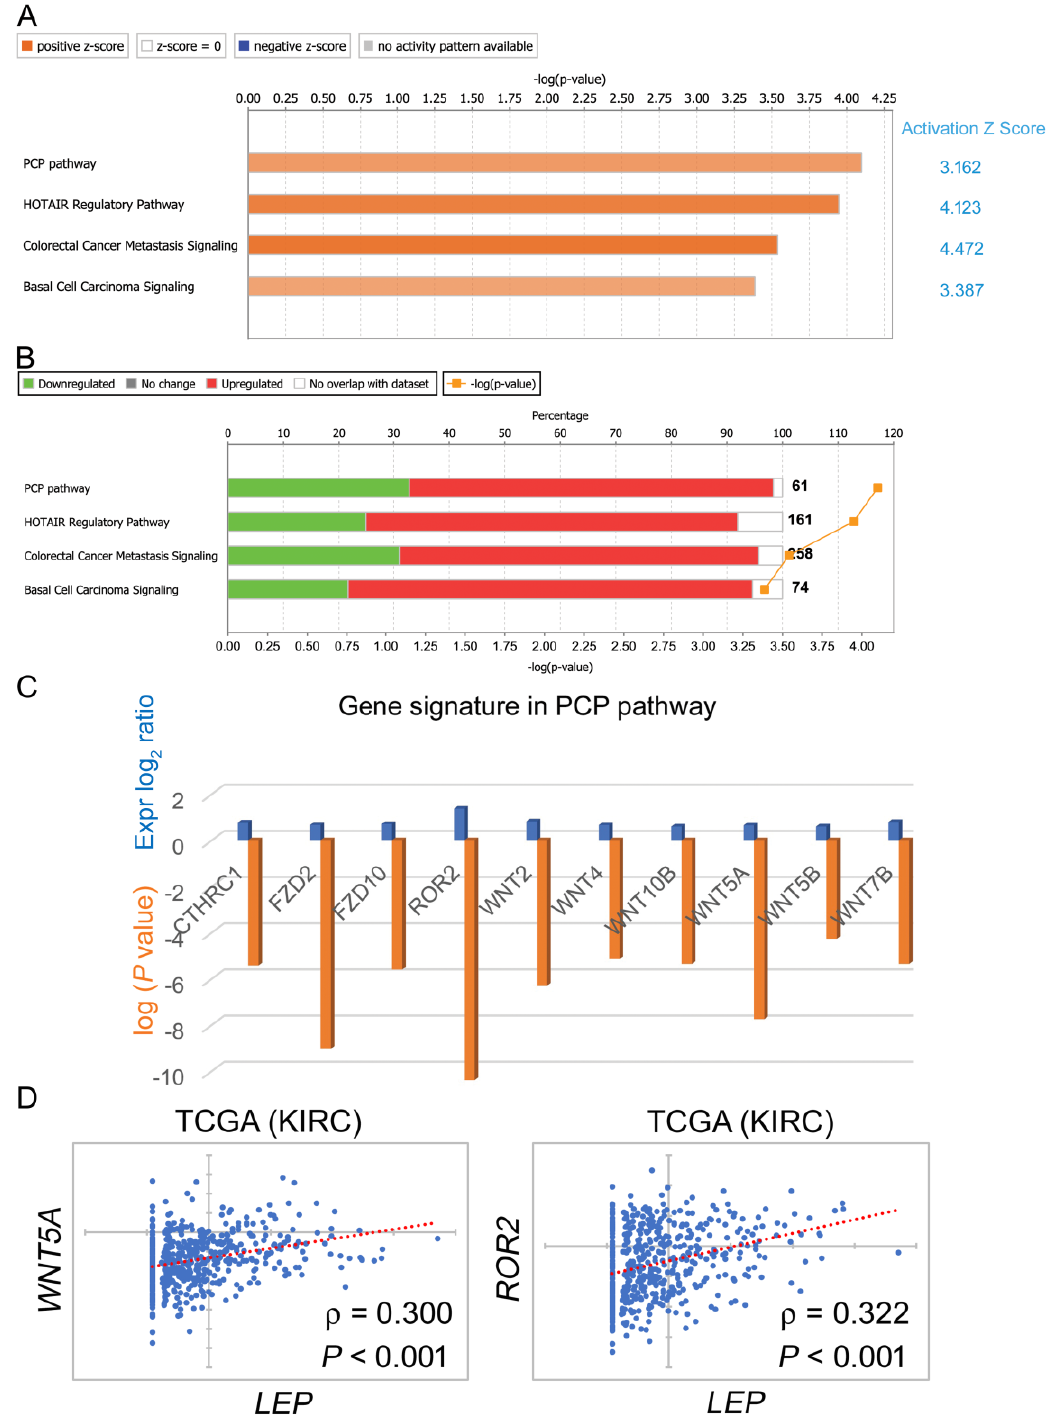
Figure 4. List of putative leptin-regulated canonical pathways via IPA. ( A ) The differentially expressed gene targets in the high leptin group were studied in the IPA platform. Pivotal canonical pathways judged by the levels of gene expression and numbers of target overlapping with the IPA database are shown along with the activation status judged by the z-score. ( B ) The distribution of up- and downregulated gene targets in each canonical pathway, ( C ) gene targets characterized with the significant expressional alterations in the PCP signaling pathway, and ( D ) Pearson correlations of WNT5A and ROR2 with LEP in the TCGA ccRCC cohort.